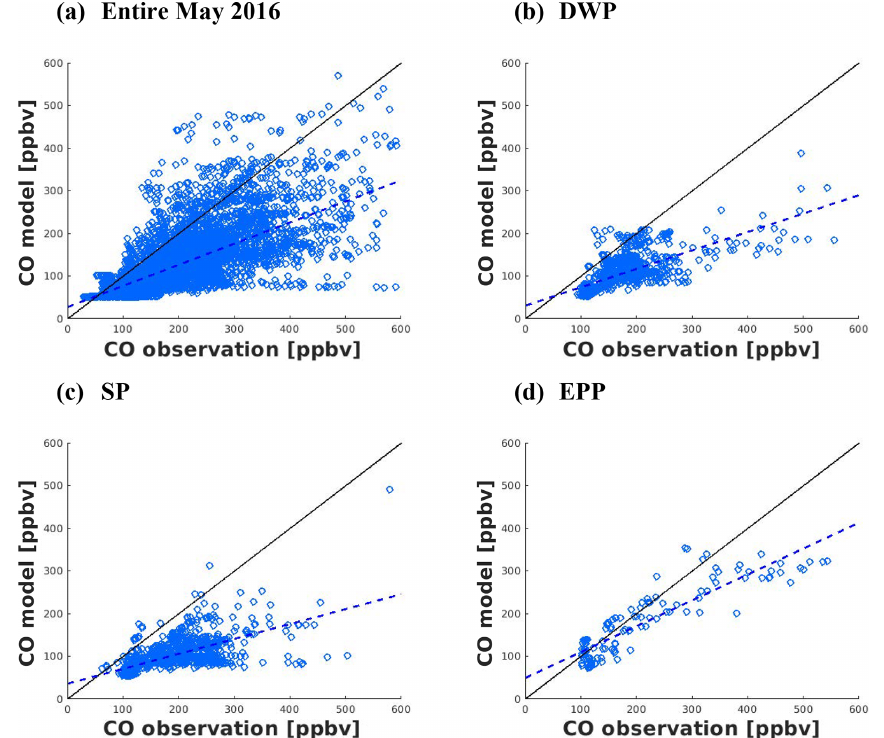
Figure 4. CMAQ model results versus aircraft CO measurements for (a) the entire month of May 2016 ( n = 6865), (b) the DWP ( n = 1750), (c) the SP ( n = 1548), and (d) the EPP ( n =